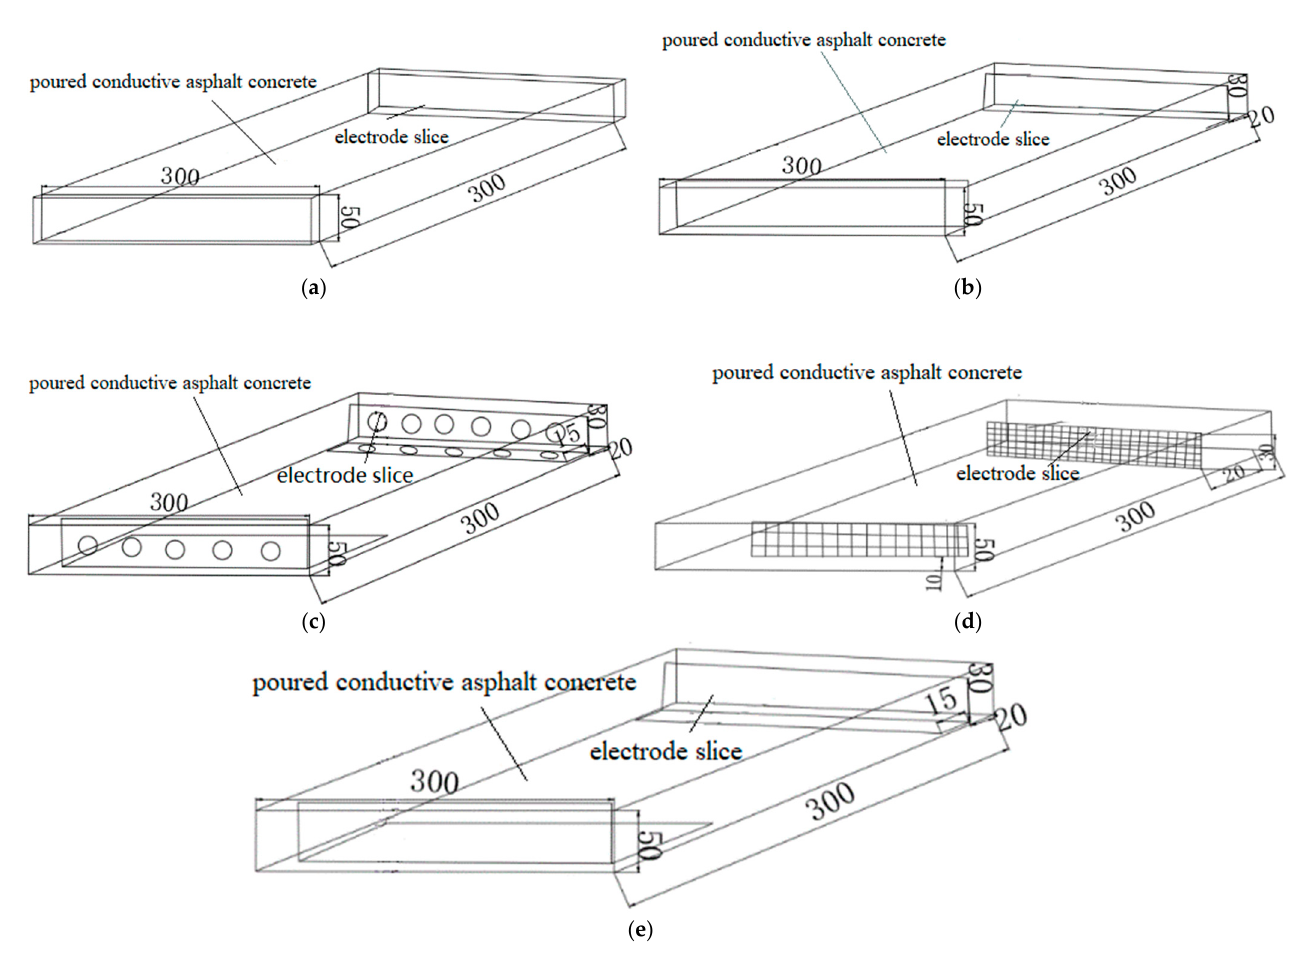
Figure 2. Design drawing of electrode layout scheme. ( a ) Layout of left and right electrodes; ( b ) Direct electrode embedded in left and right; ( c ) L electrode embedded with holes; ( d ) Left and right embedded mesh electrodes; ( e ) L electrode buried left and right.